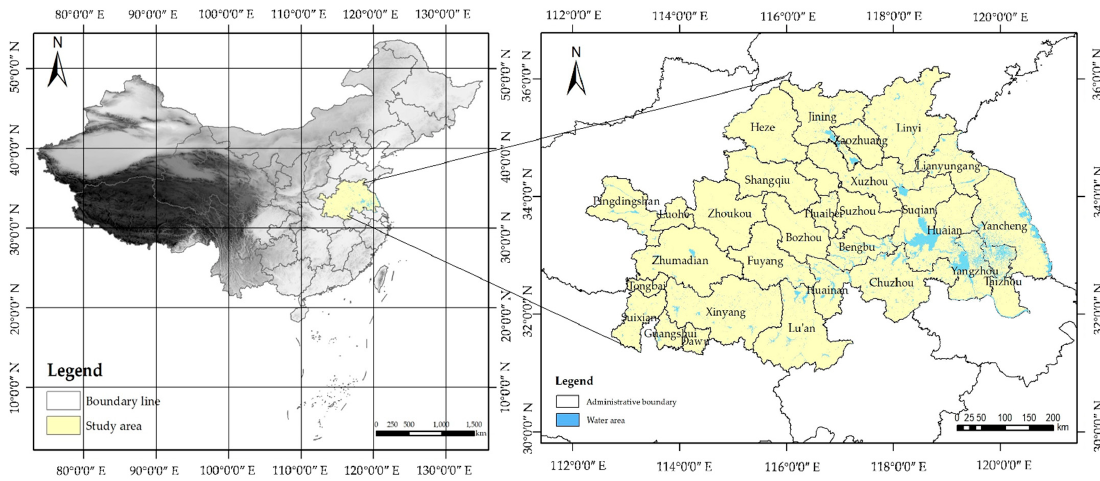
Figure 1. Map of the research area.